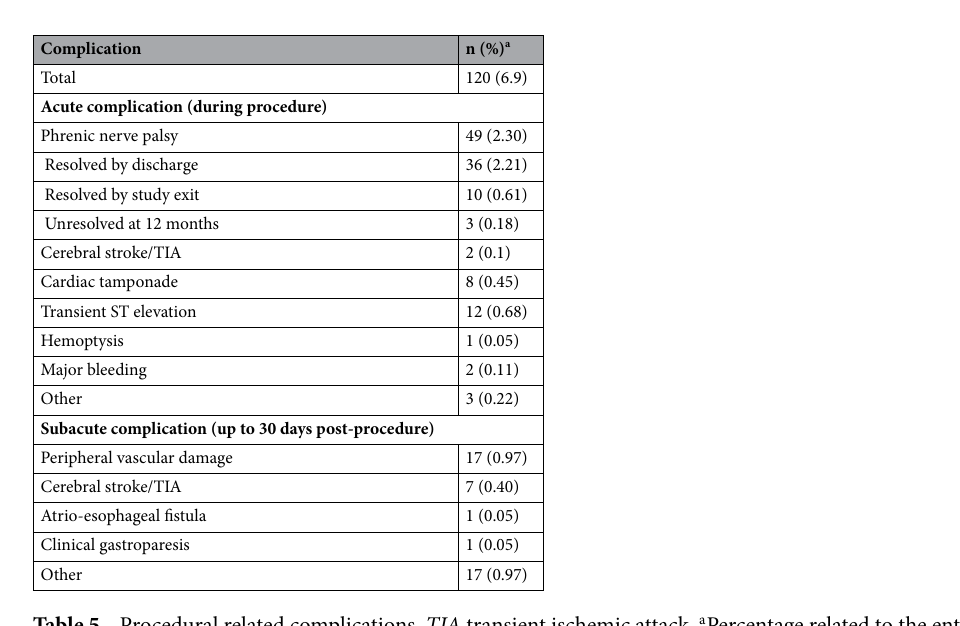
Table 5. Procedural related complications. TIA transient ischemic attack. a Percentage related to the entire